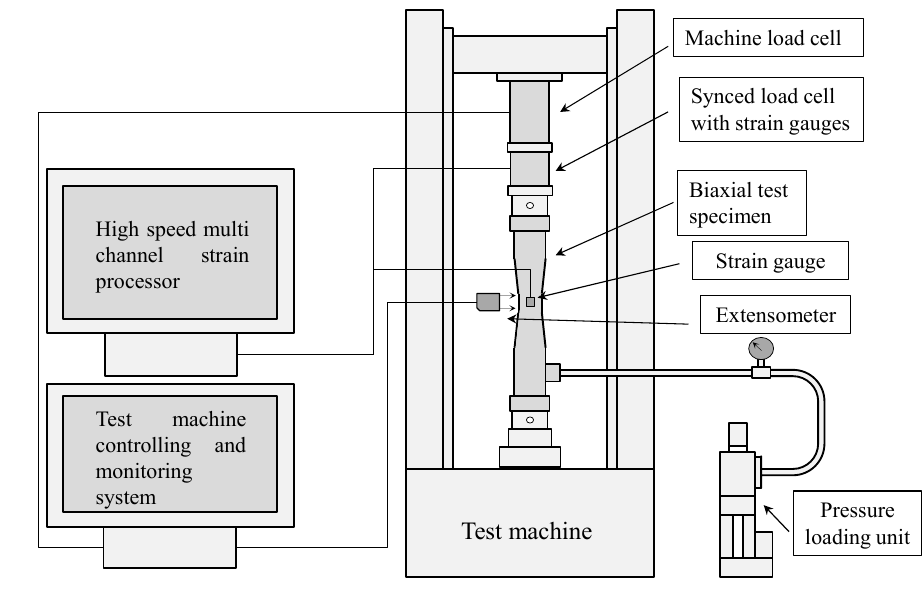
Figure 4. Sketch of biaxial testing setup.